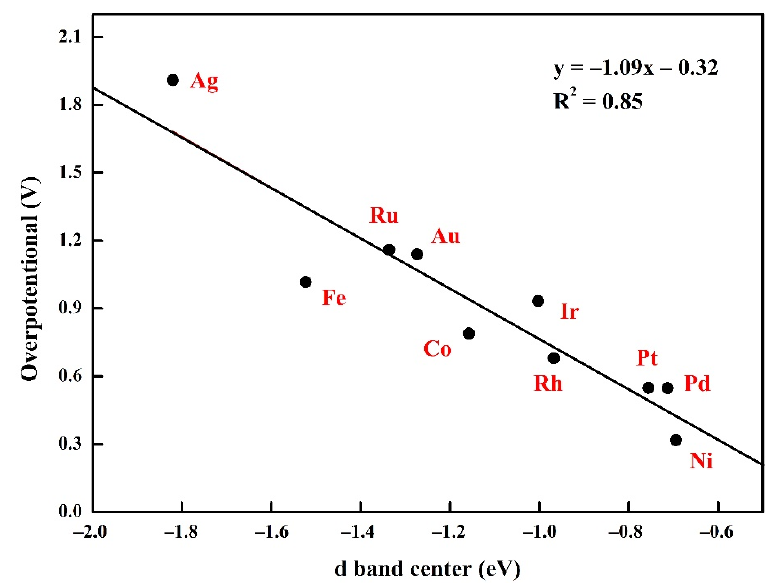
Figure 5. Calculated overpotential on different TM@MoSSe catalysts as a function of the correspond- ing d band center.